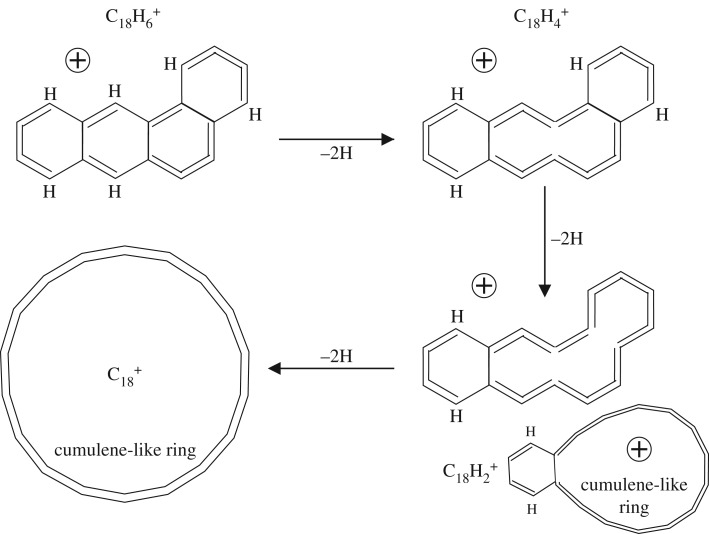
The follow-on to the alternative dehydrogenation pathway for the C18H 6+ cation to C 18+. In this case, the formation of a different bicyclic cation, C18H 2+, occurs somewhat later in the dehydrogenation sequence.